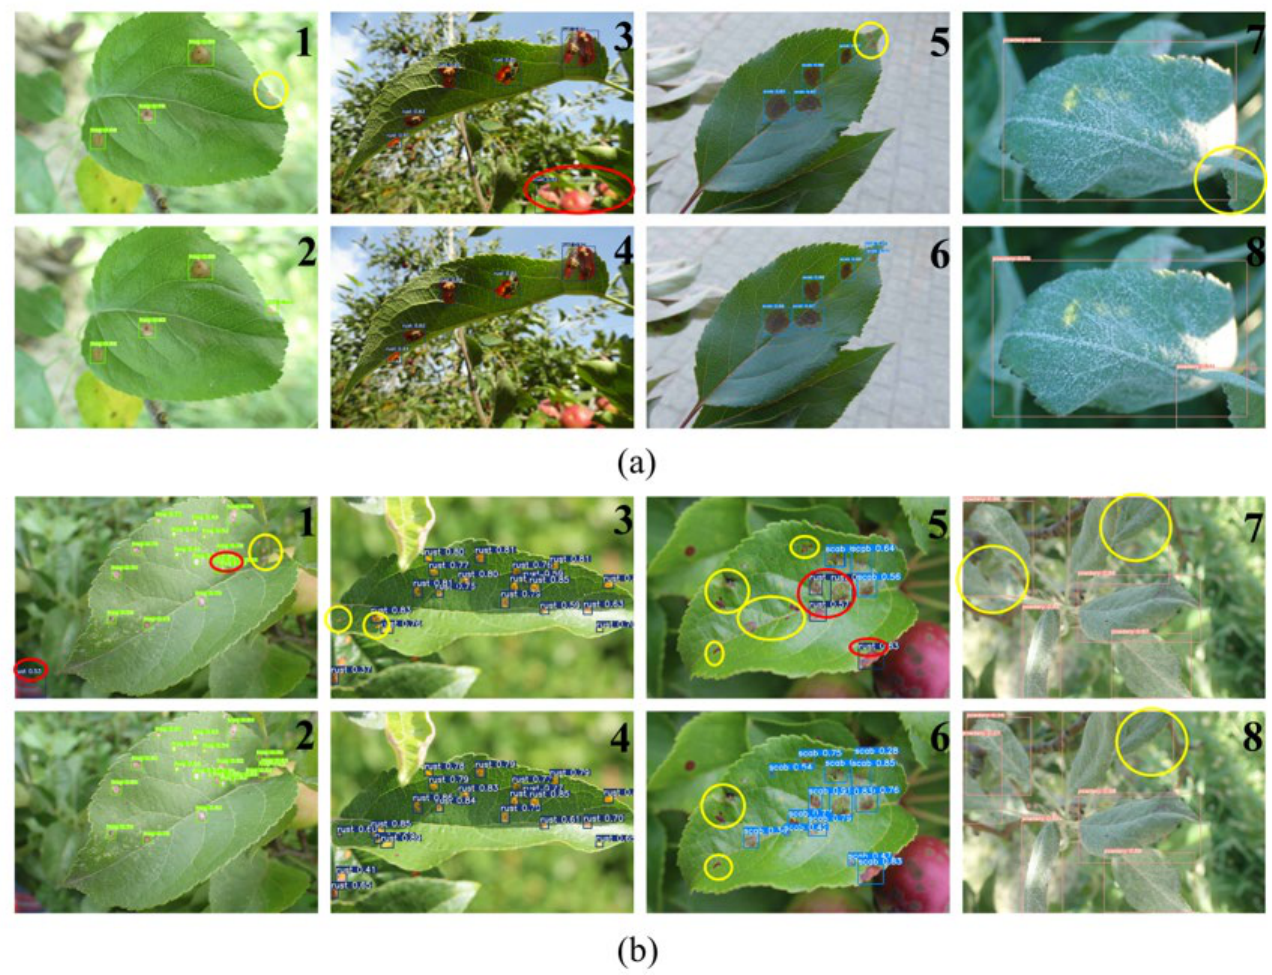
Figure 10. Comparison of detection effect of lesion (sparse and dense) before and after model improvement. ( a ) Sparse distribution; ( b ) Dense distribution. Where yellow circles represent missed detections and red circles represent false detections. Lines 1 and 3 are the YOLOv5s baseline model, and lines 2 and 4 are the improved BTC-YOLOv5s model. Numbers 1 and 2 are frogeye leaf spot, numbers 3 and 4 are rust, numbers 5 and 6 are scab, and numbers 7 and 8 are powdery